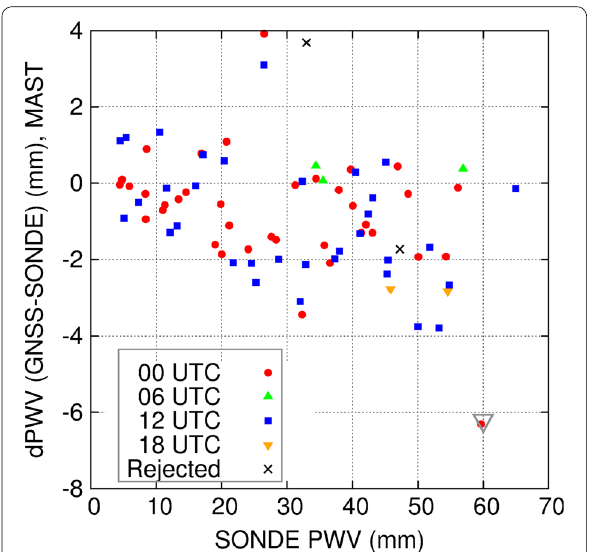
Fig. 8 Scatter diagrams of the differences in the GNSS ZD (ZHD and ZWD) obtained from the MAST measurements versus those estimated from the radiosonde observations. Plots with gray inverted triangles are a comparison with the radiosonde launched at 2331 UTC on June 10, 2017. The cause of the large difference is discussed in “Discussion and Summary”